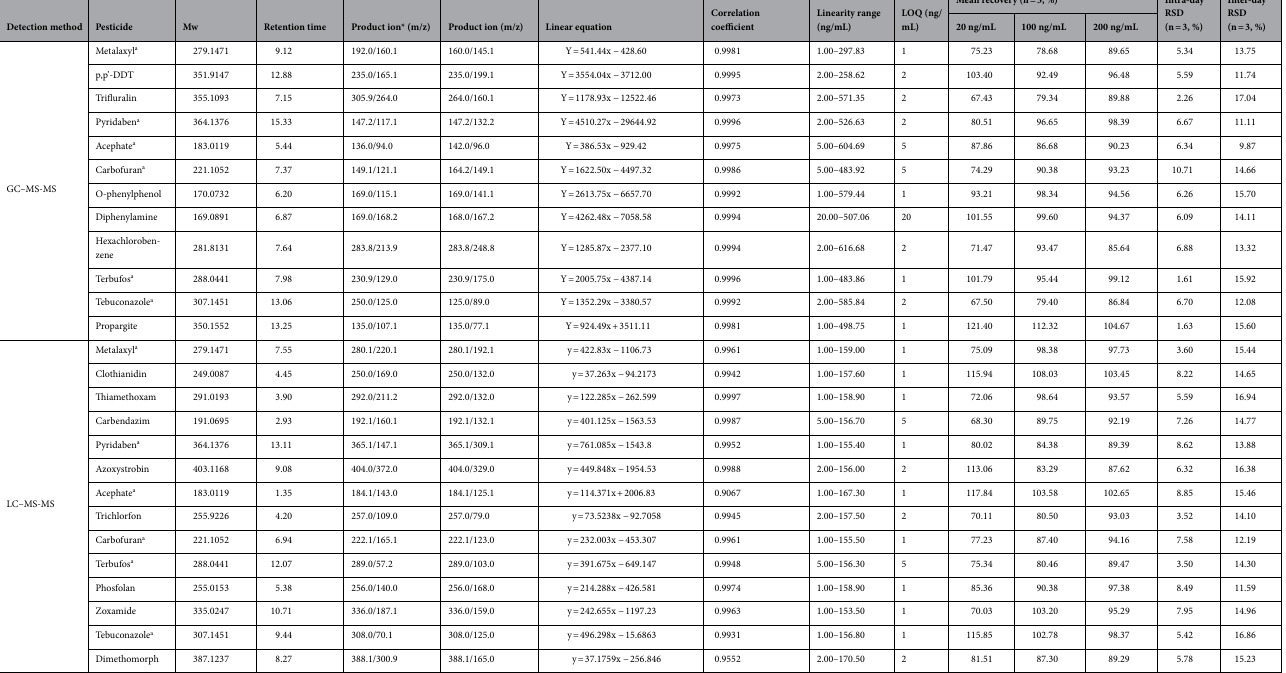
Table 1. Retention time, detected ion pairs, linear equation, correlation coefficient, linearity range, LOQ, mean recovery, intra-day RSD and inter-day RSD for pesticide residue detected in CR. a Represents that